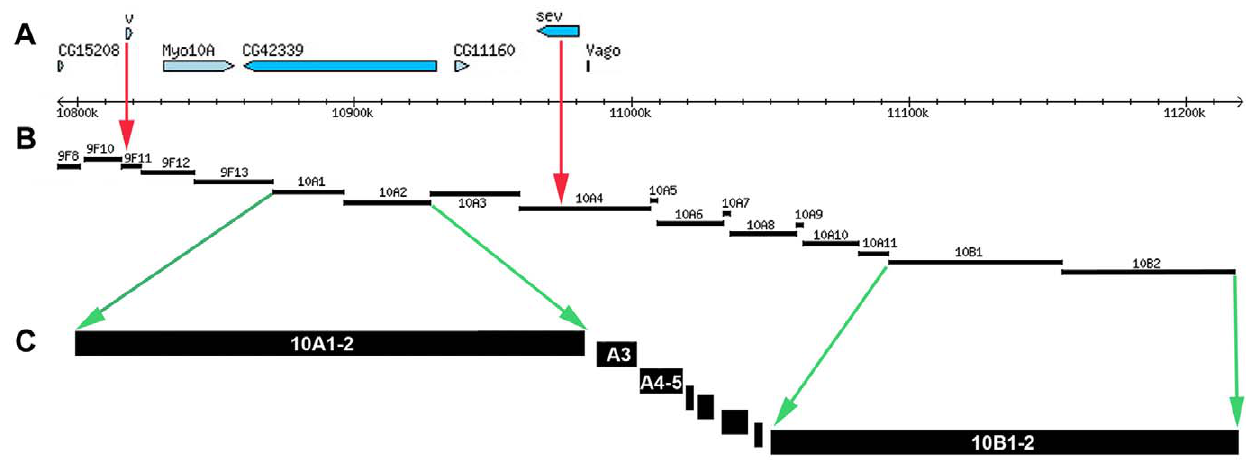
Figure 7. Comparison of extents of band/interbands in polytene chromosomes according to Flybase r5.25 (A, B) and to the data of this study (C). Physical DNA map is situated between 10792800 and 11220400 positions of the map of Flybase.